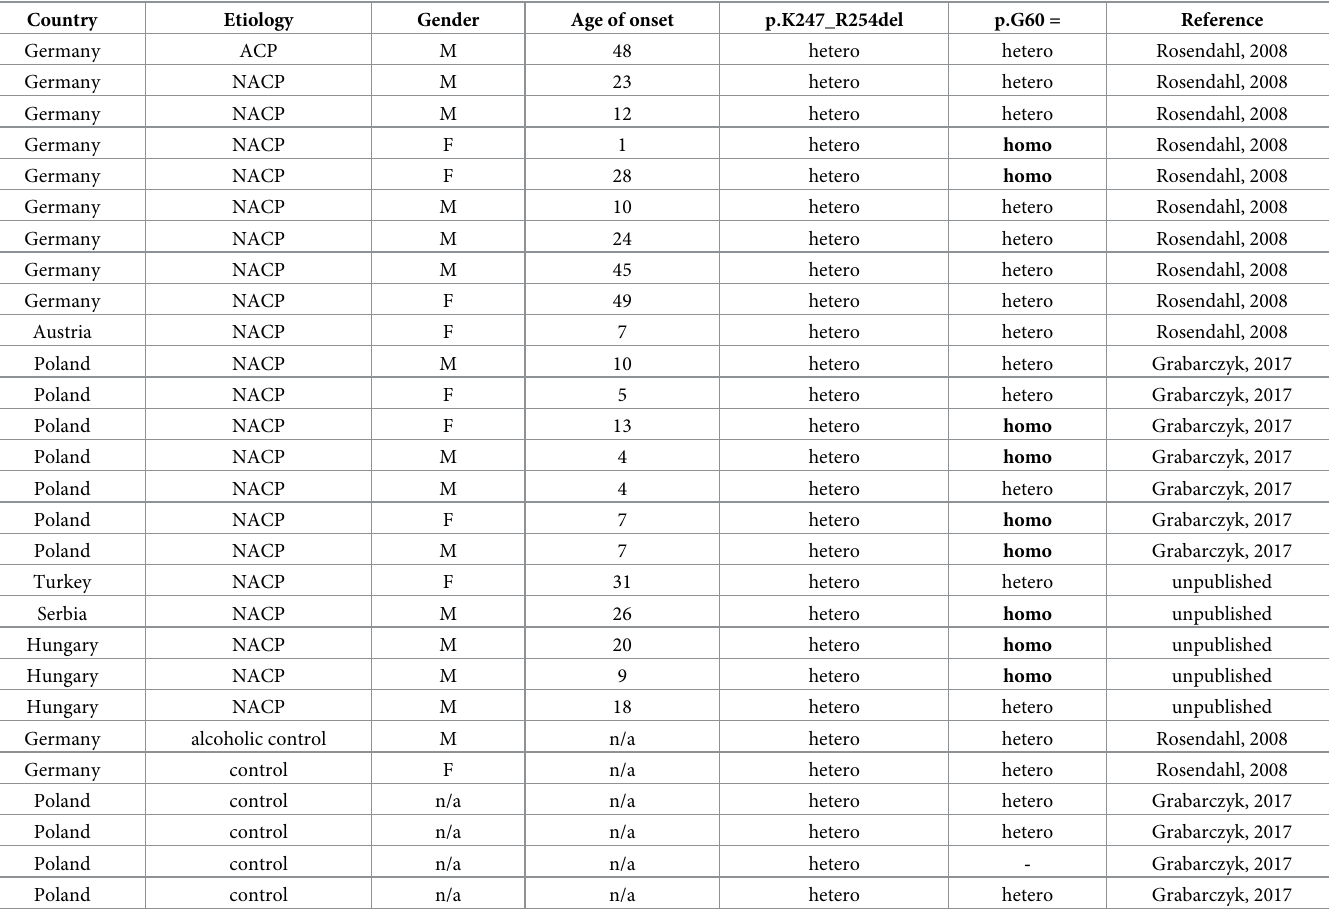
Table 2. Association of the CTRC c.738_761del24 (p.K247_R254del) microdeletion with the common CTRC variant c.180C > T (p.G60